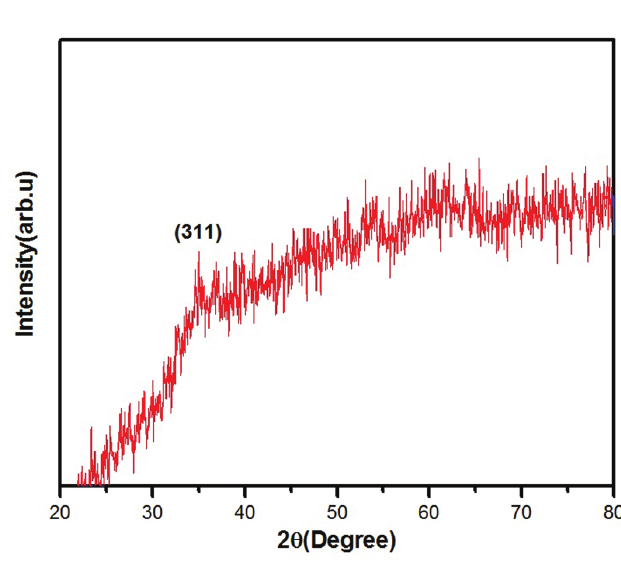
FIGURE 2 ‑ XRD pattern of the prepared Mn‑Ni@Fe particles.